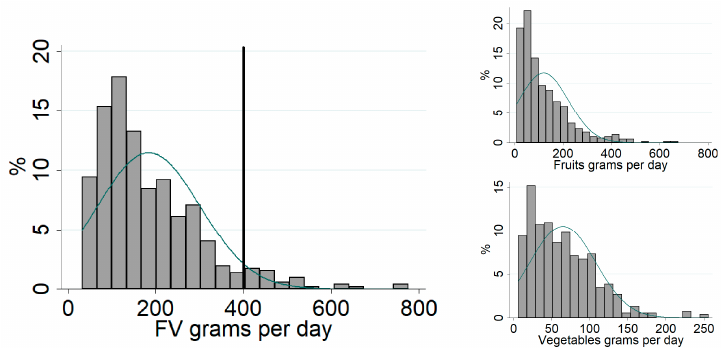
Figure 1. Distribution of usual consumption in grams of fruits and vegetables by adolescents. ISA-Capital, São Paulo city, Brazil, 2015. Source: 2015 ISA-Capital. Table 1. Demographic, socioeconomic, lifestyle factors, and street markets density by fruits and vegetables consumption of adolescents living in the city of São Paulo, Brazil, 2015.